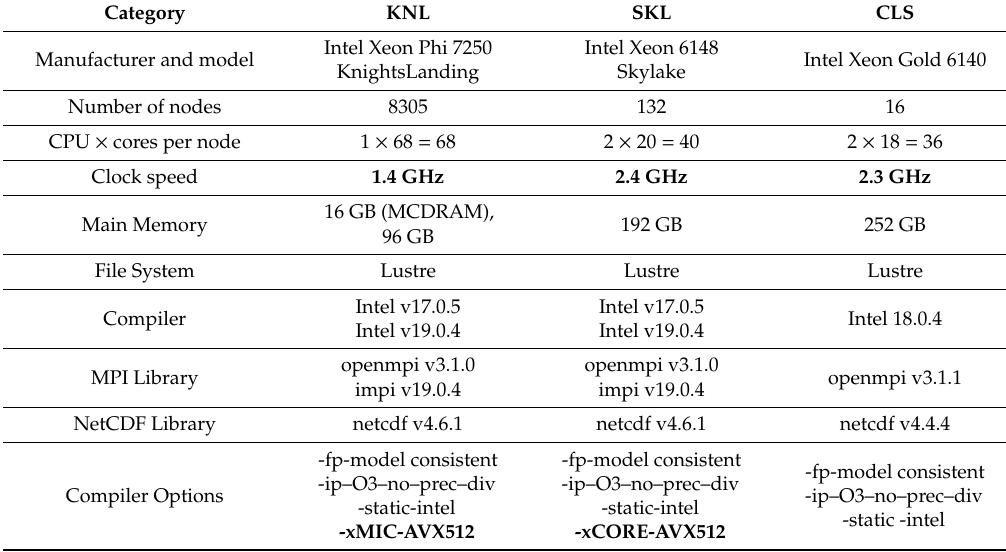
Table 1. Summarized specifications for Nurion (Knights Landing (KNL) and Skylake (SKL)) and a general cluster system (CLS).